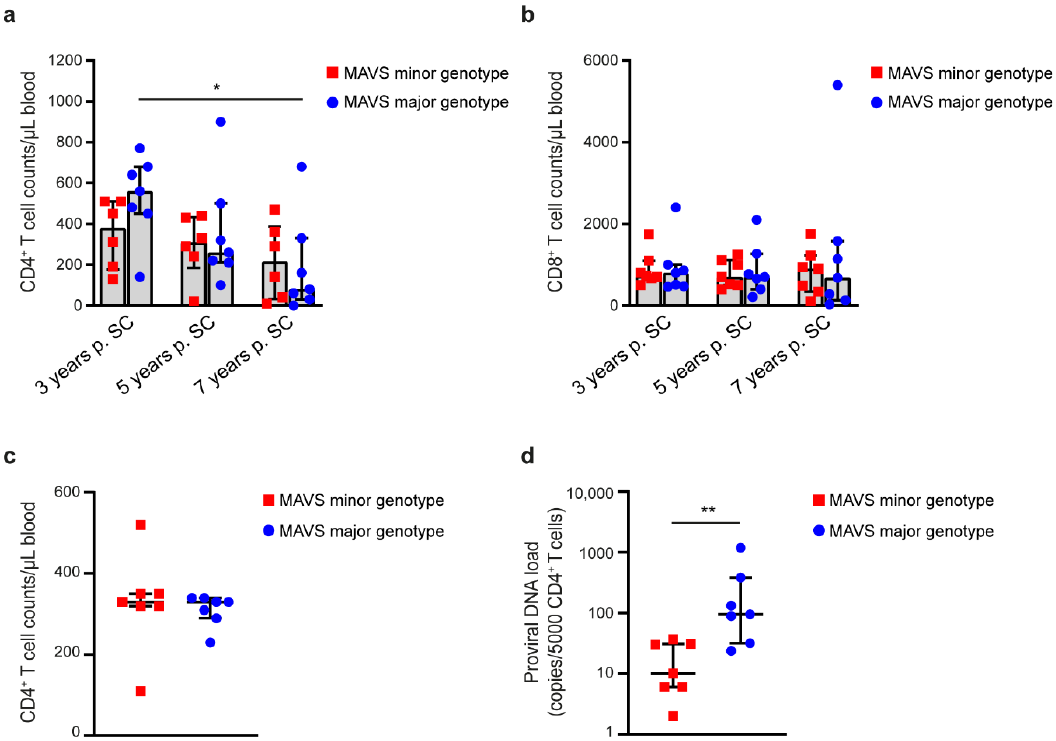
Figure 1. MAVS minor genotype is associated with sustained CD4 + T cell counts and a decreased level of cell-associated proviral DNA load during human immunodeficiency virus 1 (HIV-1) infection. ( a ) CD4 + T cell counts were assessed at 3, 5, and 7 years post seroconversion (p.SC) in untreated HIV-1-infected individuals carrying a MAVS minor or MAVS major genotype. ( b ) CD8 + T cell counts were assessed at 3, 5, and 7 years p.SC in individuals carrying a MAVS minor or MAVS major genotype. ( c ) CD4 + T cell counts and ( d ) the number of HIV-1 DNA copies per 5000 CD4 + T cells using qPCR were obtained from untreated HIV-1-infected individuals carrying the MAVS minor or MAVS major genotype 3.5–8.5 years p.SC. Each square or dot represents a different study participant (median ± IQR). All significant differences are indicated: * p < 0.05, ** p < 0.01, paired Wilcoxon test ( a ) and